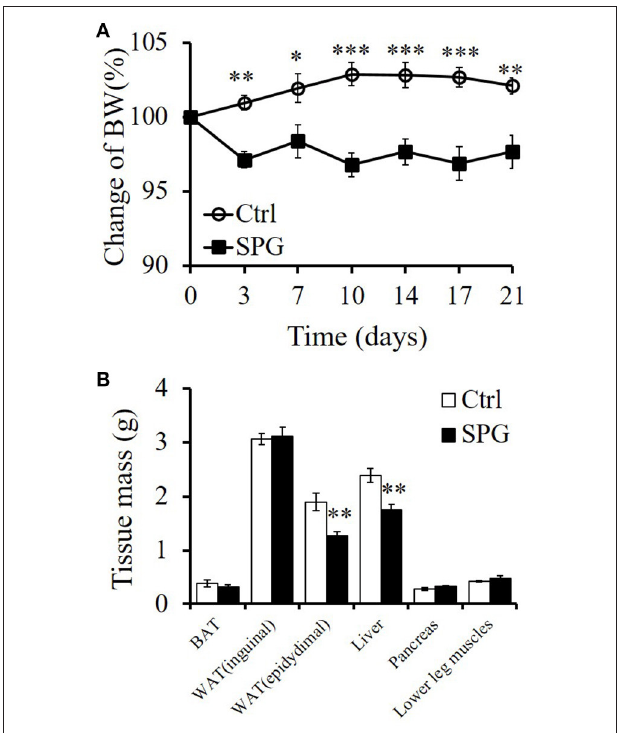
FIGURE 2 | Supaglutide attenuates body weight gain in DIO mice. (A) Body weight gain of the PBS- and supaglutide- treated mice was recorded and expressed as the percentage of weight at the day before first injection. Significant difference between control and SPG is determined using two-way RM ANOVA method. (B) Weight of tissues. Significant difference between control and SPG is determined using unpaired Student’s t -test. All values are means ± SE ( n = 5 for each group). * p < 0.05; ** p < 0.01; *** p < 0.001.